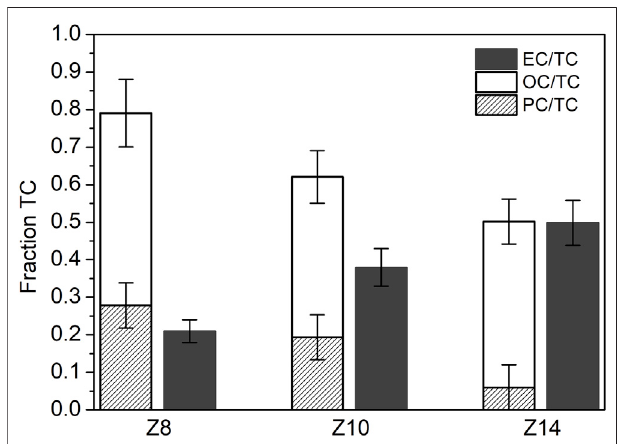
FIGURE 4 | Fractions of OC (Organic Carbon evolving in He), PC (Pyrolytic Carbon) and EC (Elemental Carbon) over the total carbon (TC) measured for each sample analyzed in this work, i.e., soot at Z = 8 mm, Z = 10 mm and Z = 14